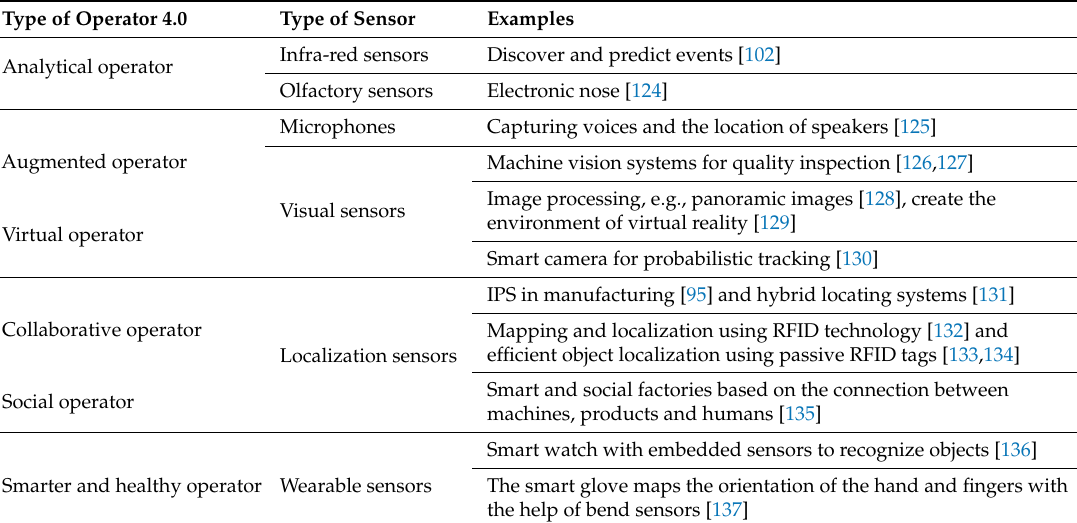
Table 5. Sensors of Operator 4.0